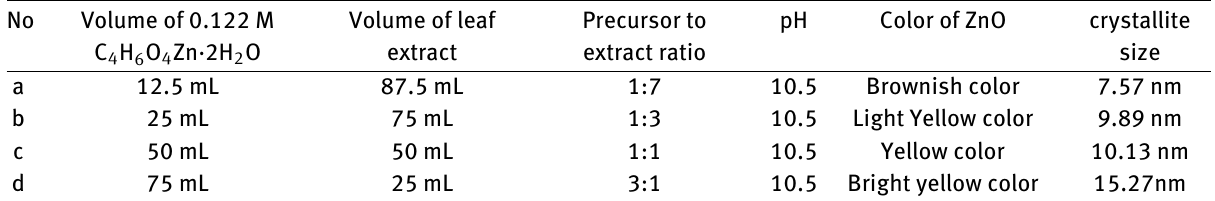
Table 1: Ratio of precursor to plant extract used to prepare ZnO NPs No Volume of 0.122 M